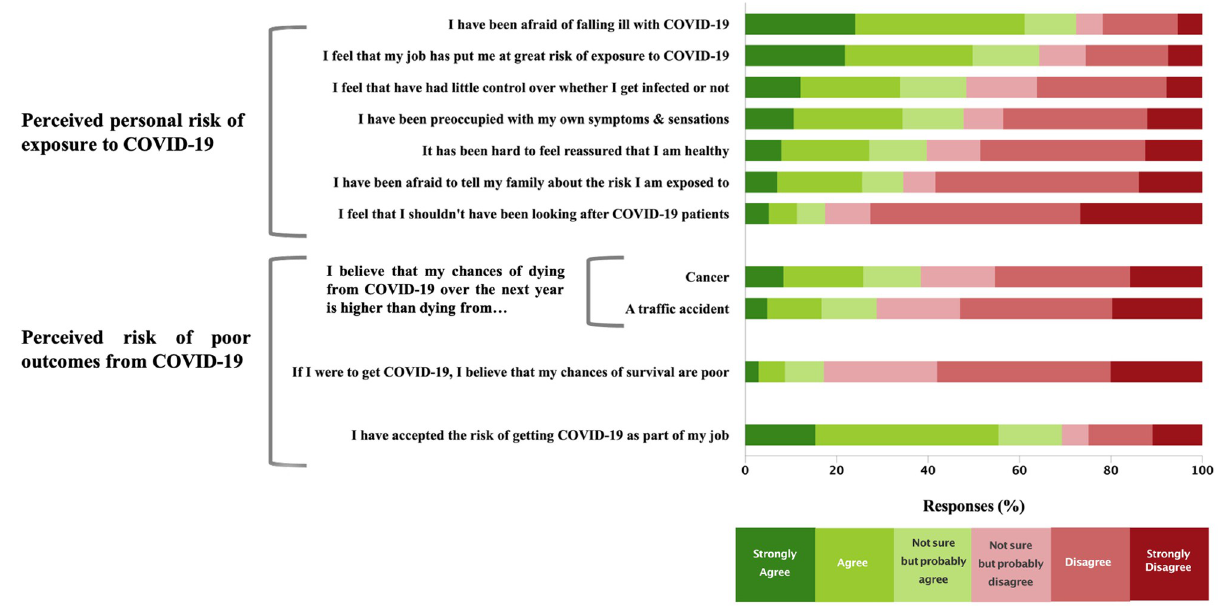
Fig 1. Perceived risks of personal exposure & poor outcomes among hospital workers during the COVID-19 pandemic.